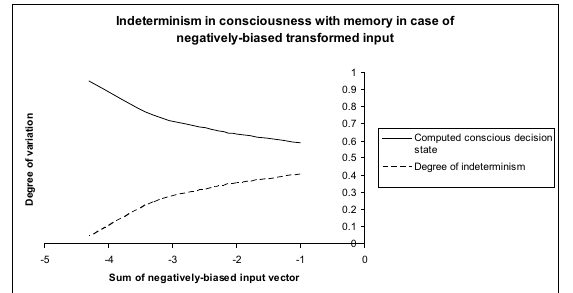
Fig. 29. Consciousness in complete memory system (transformed excitation, fair C2).